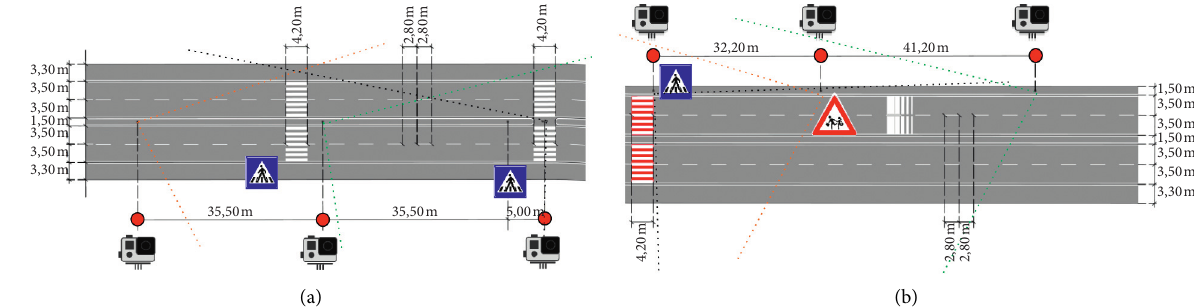
Figure 3: Range of vision of cameras for white zebra crossing (a) and red and white zebra crossing